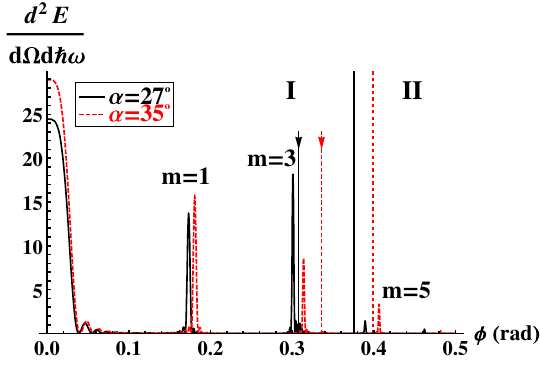
FIG. 6. The distribution of x-ray SPR over the conical surface, i.e., at θ ¼ arccos ð β − 1 sin α Þ [see Eq. (28)]. Here γ ¼ 4 × 10 4 (electron energy of FACET, SLAC: E ¼ 28 GeV), ℏ ω p ¼ 26 . 1 eV (beryllium), d ¼ 0 . 9 μ m, a ¼ 0 . 45 μ m, b ¼ 0 . 1 μ m, black curve α ¼ 27 °, for the dashed red curve α ¼ 35 °. The thick tall lines correspond to the value dividing angles into two parts – I and II, where Eq. (23) is satisfied and not satisfied, respectively. The thin lines with arrows correspond to the ϕ from Eq. (25) or min ≈ 0 . 31 rad, for the red dashed Eq. (47). For the black curve ϕ min ≈ 0 . 34 curve ϕ min